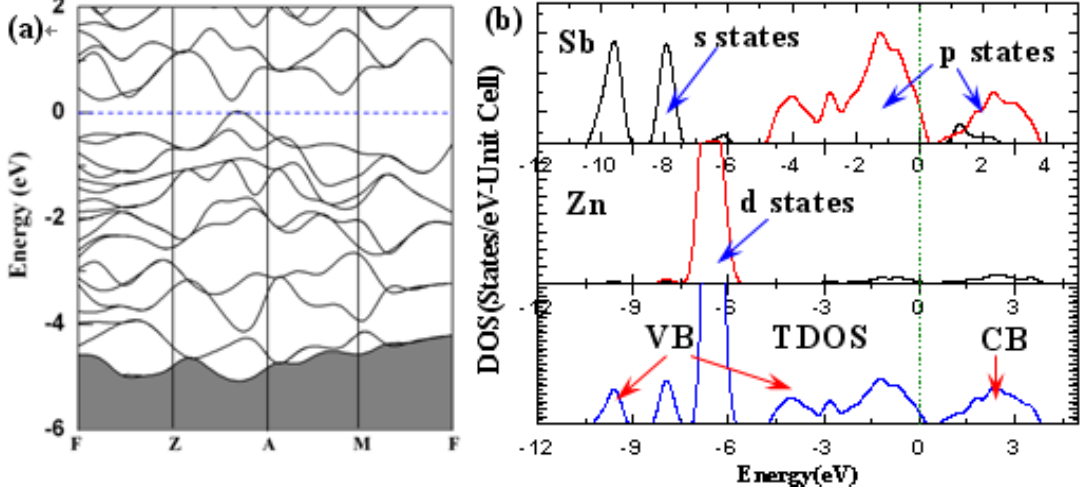
Figure 2. ( a ) The calculated band structure; ( b ) Total and partial densities of states of Zn Sb . The Fermi level ( E 64 64